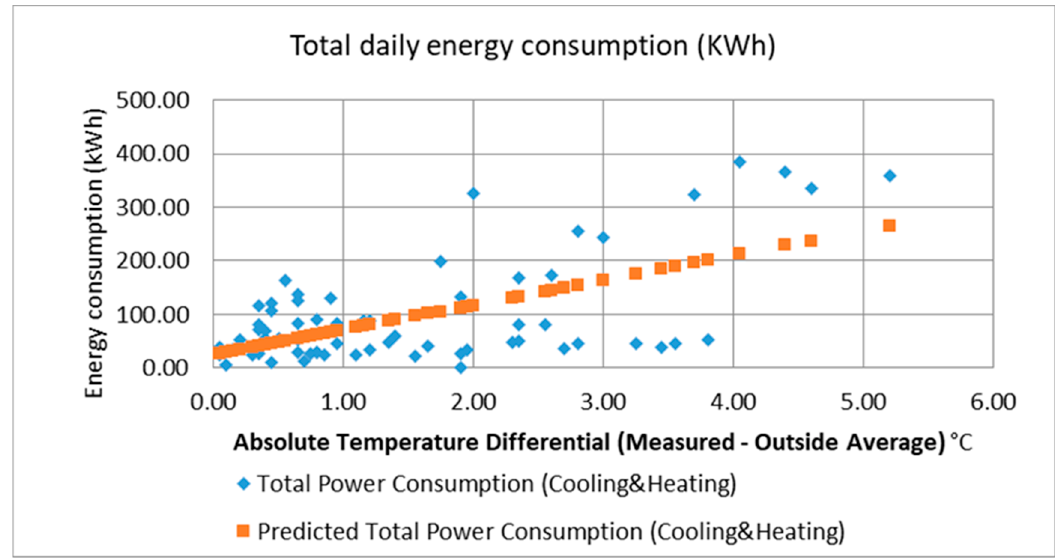
Figure 8. Comparison of total energy consumption and temperature differentials. Daily total energy consumption vs. temperature differential (outside average—measured in the greenhouse).